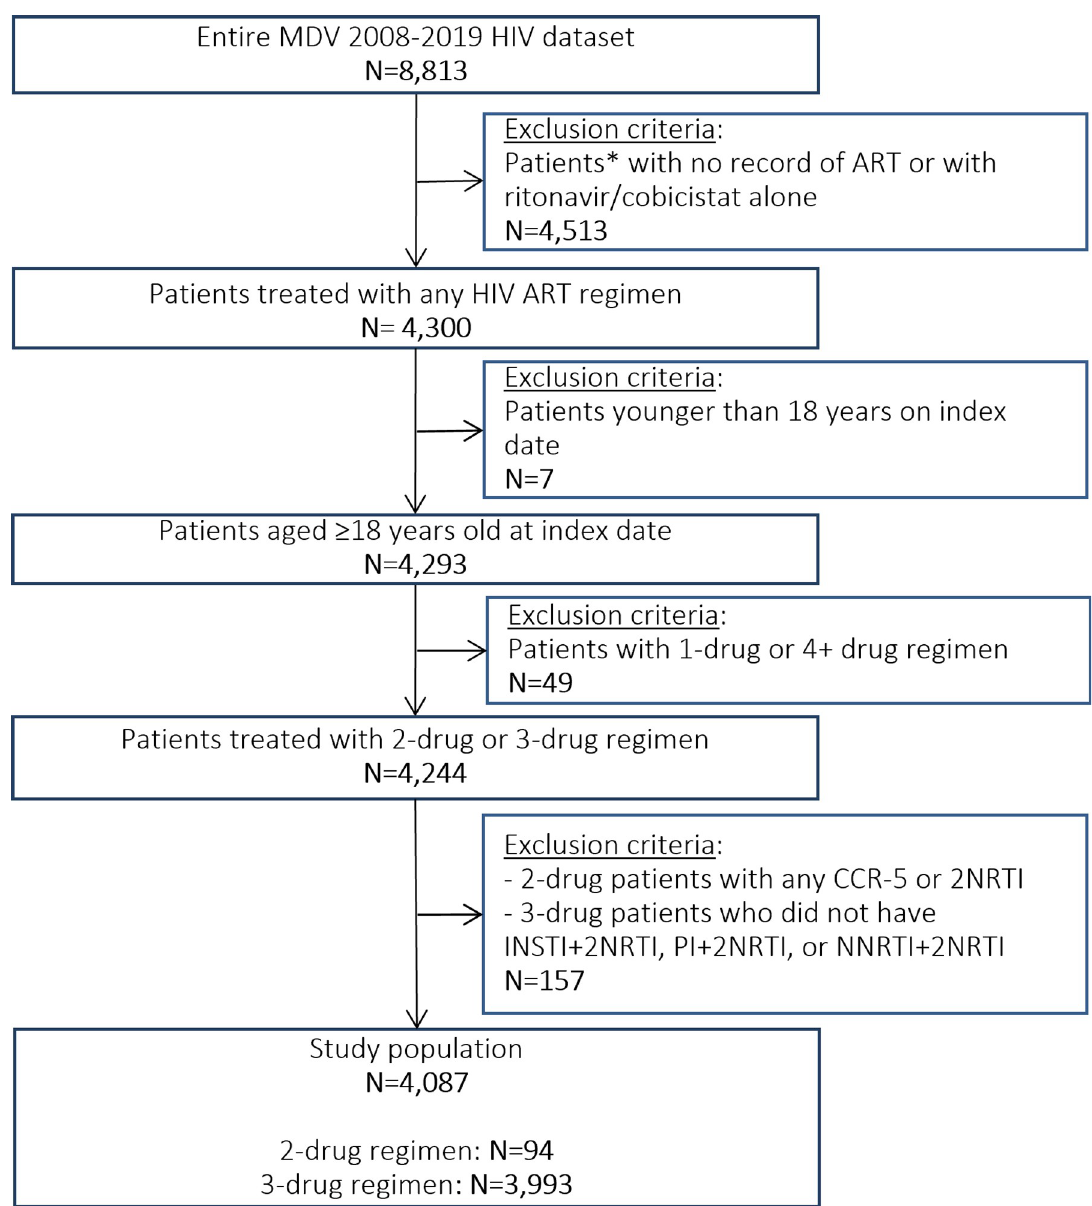
Fig 1. Flow chart of cohort attrition. � Individuals in this study were selected from a hospitals-based database, thus are referred to as “patients” in this